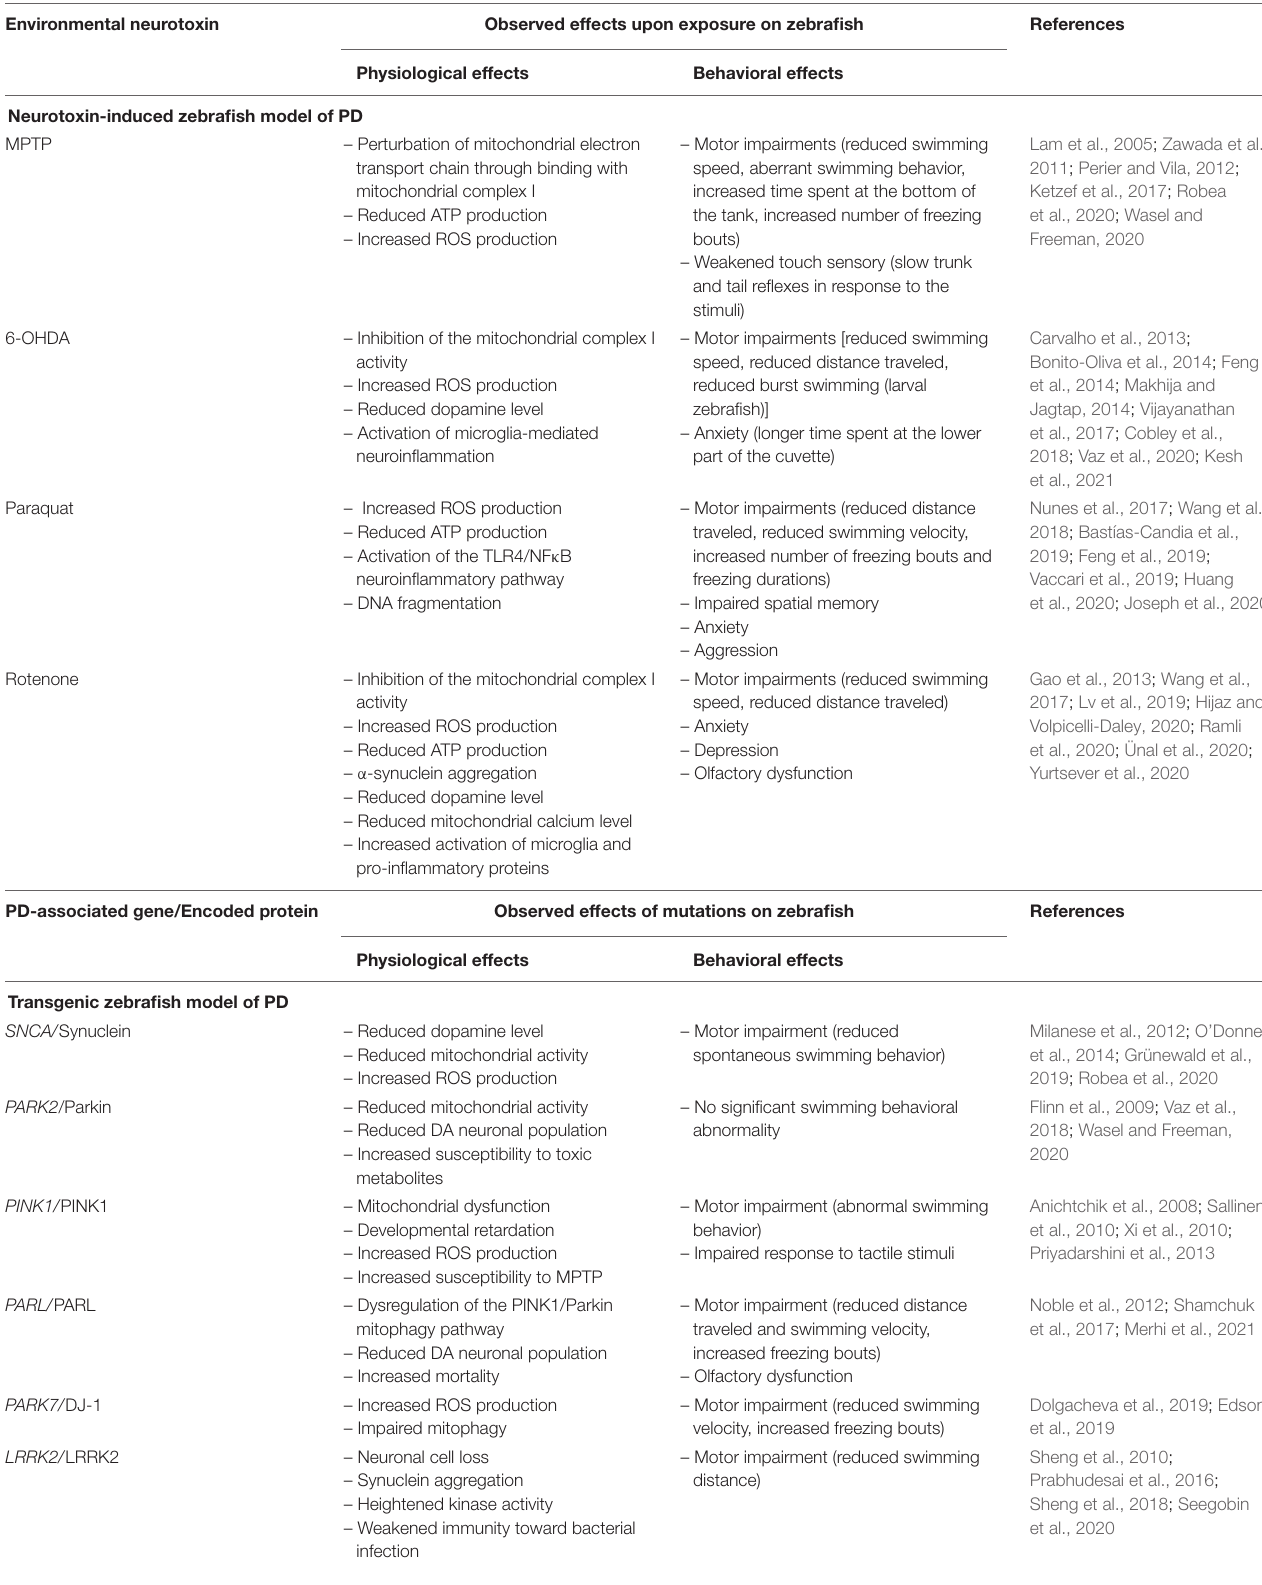
TABLE 2 | Summary of the physiological and behavioral effects observed on the neurotoxin-induced and transgenic zebrafish model of PD. Environmental neurotoxin Observed effects upon exposure on